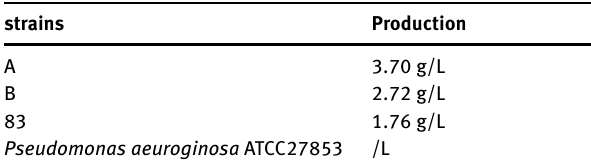
Table 3: Biosurfactant production